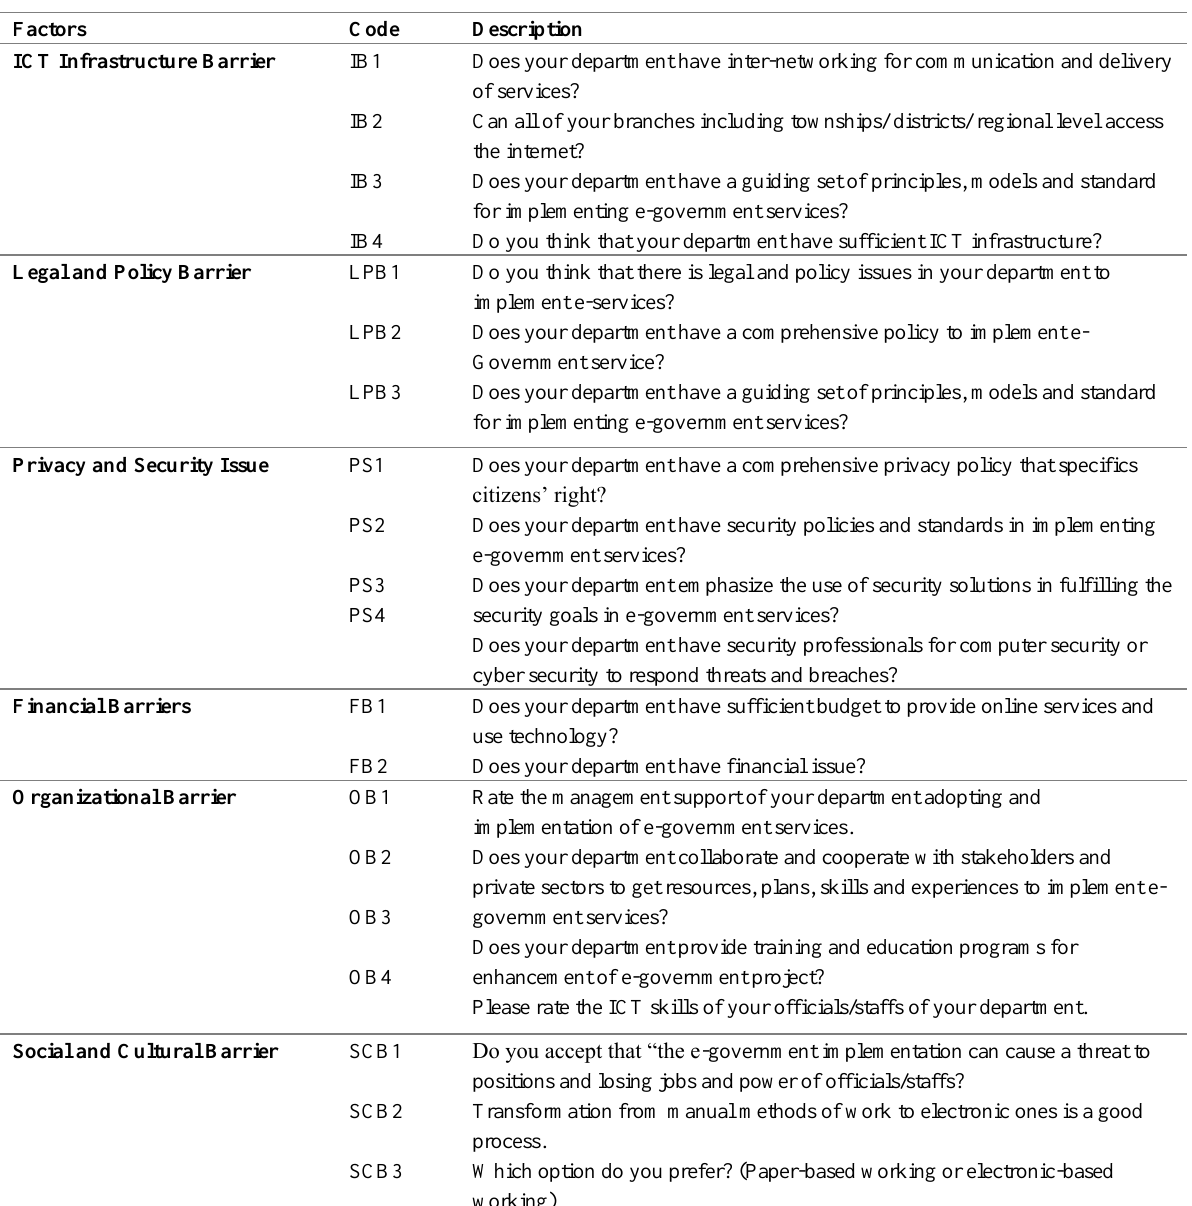
Table 2: The Questionnaire Utilized to Explore the Challenges Faced by The Government Agencies in Implementing G2b E-